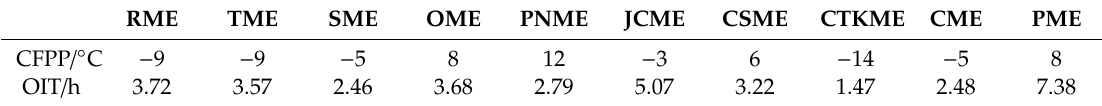
Table 3. Cold filter plugging point and oxidation induction time of